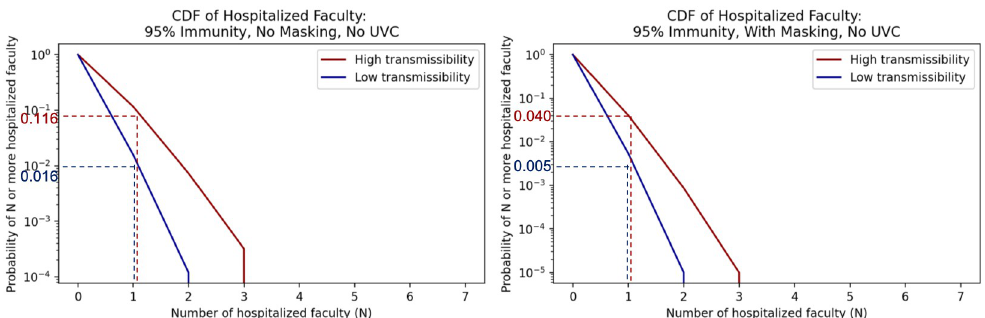
Fig 8. Inverse cumulative density functions for the total number of faculty hospitalized under the different scenarios. Each graph shows the curve of the probability of exceeding a given number of hospitalizations.